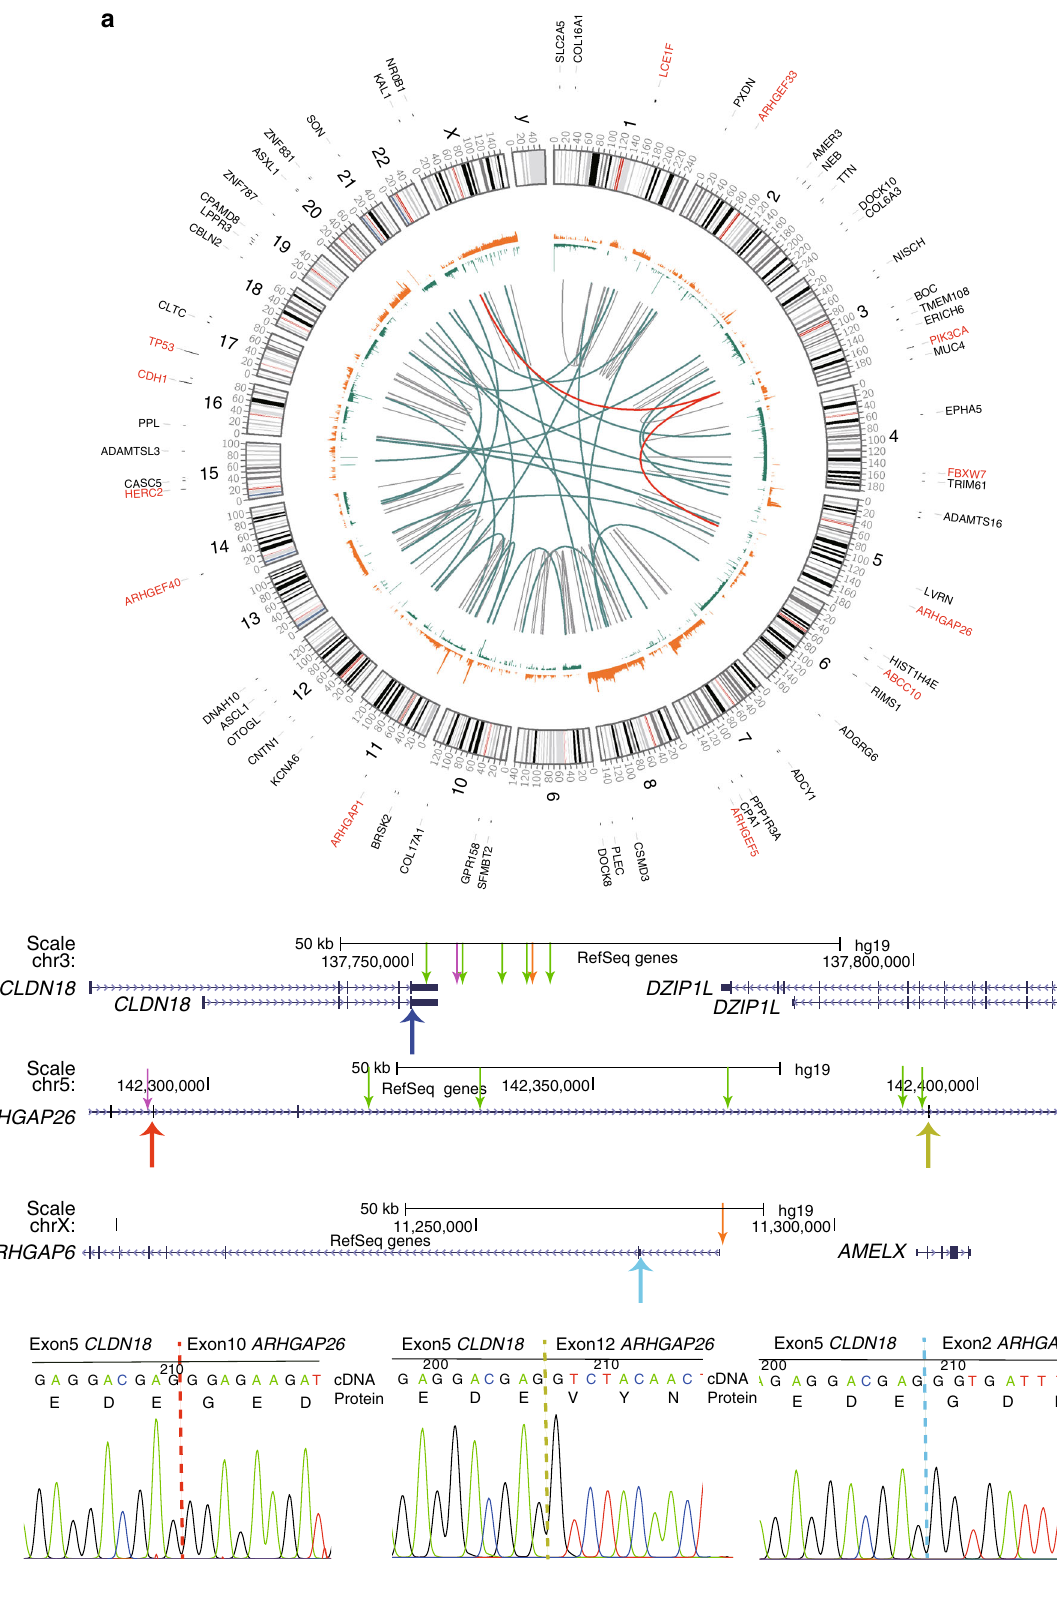
signi fi cantly enriched in patients in M1 stage ( P = 0.001, Logistic regression test) and nervous invasion ( P = 0.002, Logistic regression test). TP53 mutations occurred more frequently in tumors located at upper region of stomach ( P = 0.05, Logistic regression